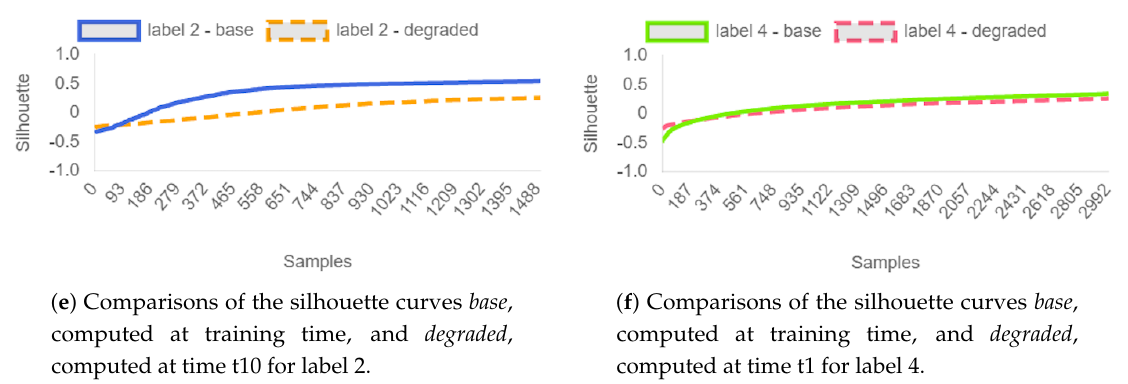
Figure 7. SERENA cloud dashboard for the self-assessment